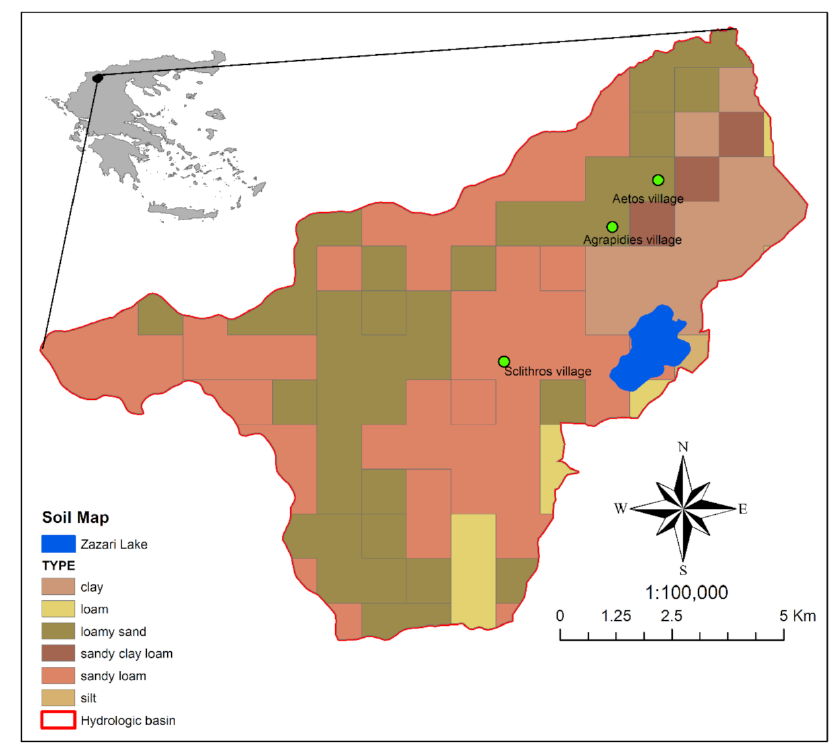
Figure 4. Spatial extent of the soil types in the hydrological model of Lake Zazari